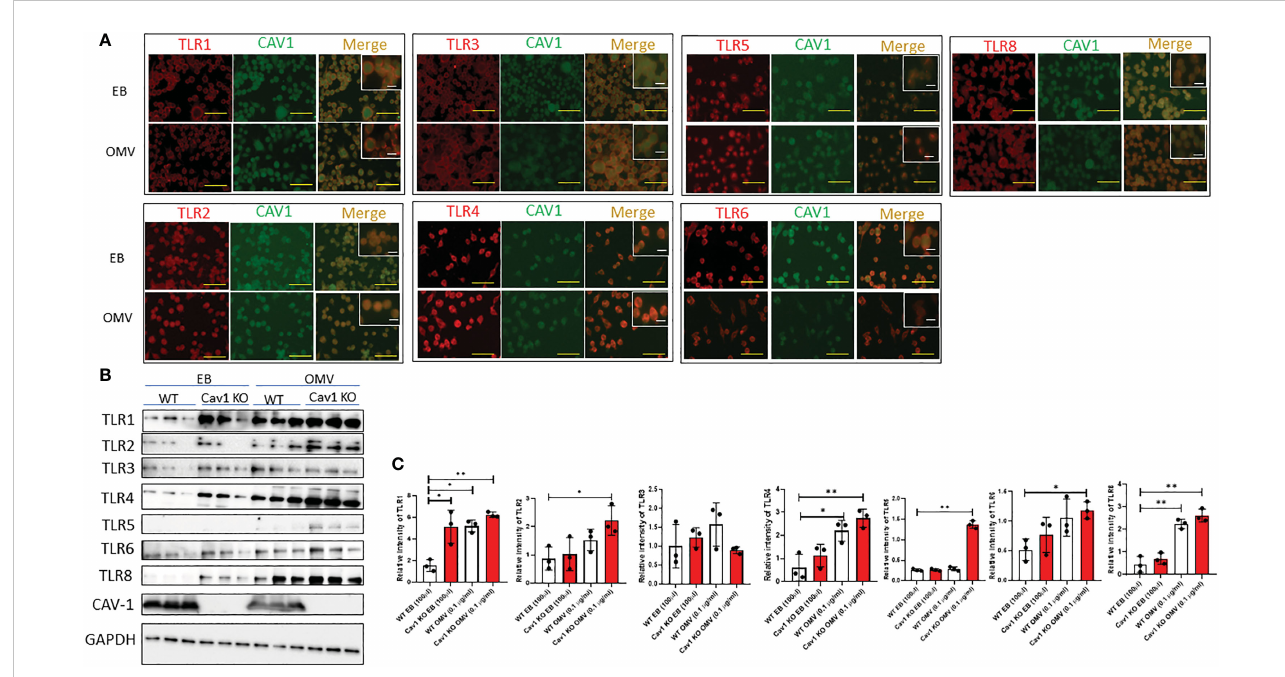
FIGURE 3 Effect of Cav-1 on the expression of various TLRs induced by OMV. WT AM was treated with 0.1mg/ml of OMV for 3h. Representative fl uorescence microscopic images (A) demonstrated the expression of different TLRs (red) and cav-1 (green) after EB/OMV treatments. (magni fi cation = ×20; scale bar (yellow) = 50 m m & magni fi cation = ×63; scale bar (white) = 10 m m). Western blot analysis (B) demonstrated the expression of different TLRs. Bar graphs (C) show the quanti fi cation results of TLRs in AM GAPDH was used as internal control, and the control value was considered one unit (n=3). Results were expressed as mean ± SD. Statistical Analysis was performed non-parametrically using the One-way Analysis of variance (ANOVA) with Tukey ’ s multiple comparison tests to determine signi fi cant differences between the experimental groups. *p < 0.05 and **p < 0.01 set as Statistical signi fi